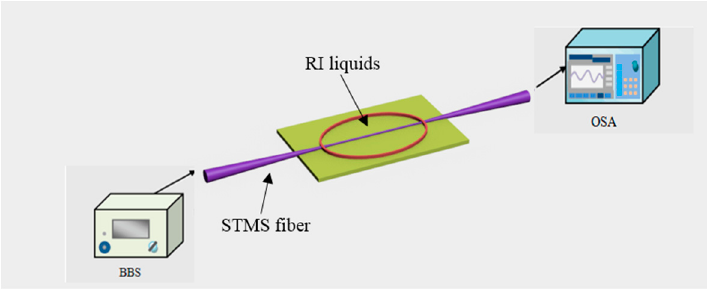
Figure 19. Schematic diagram of experimental setup for RI sensing.